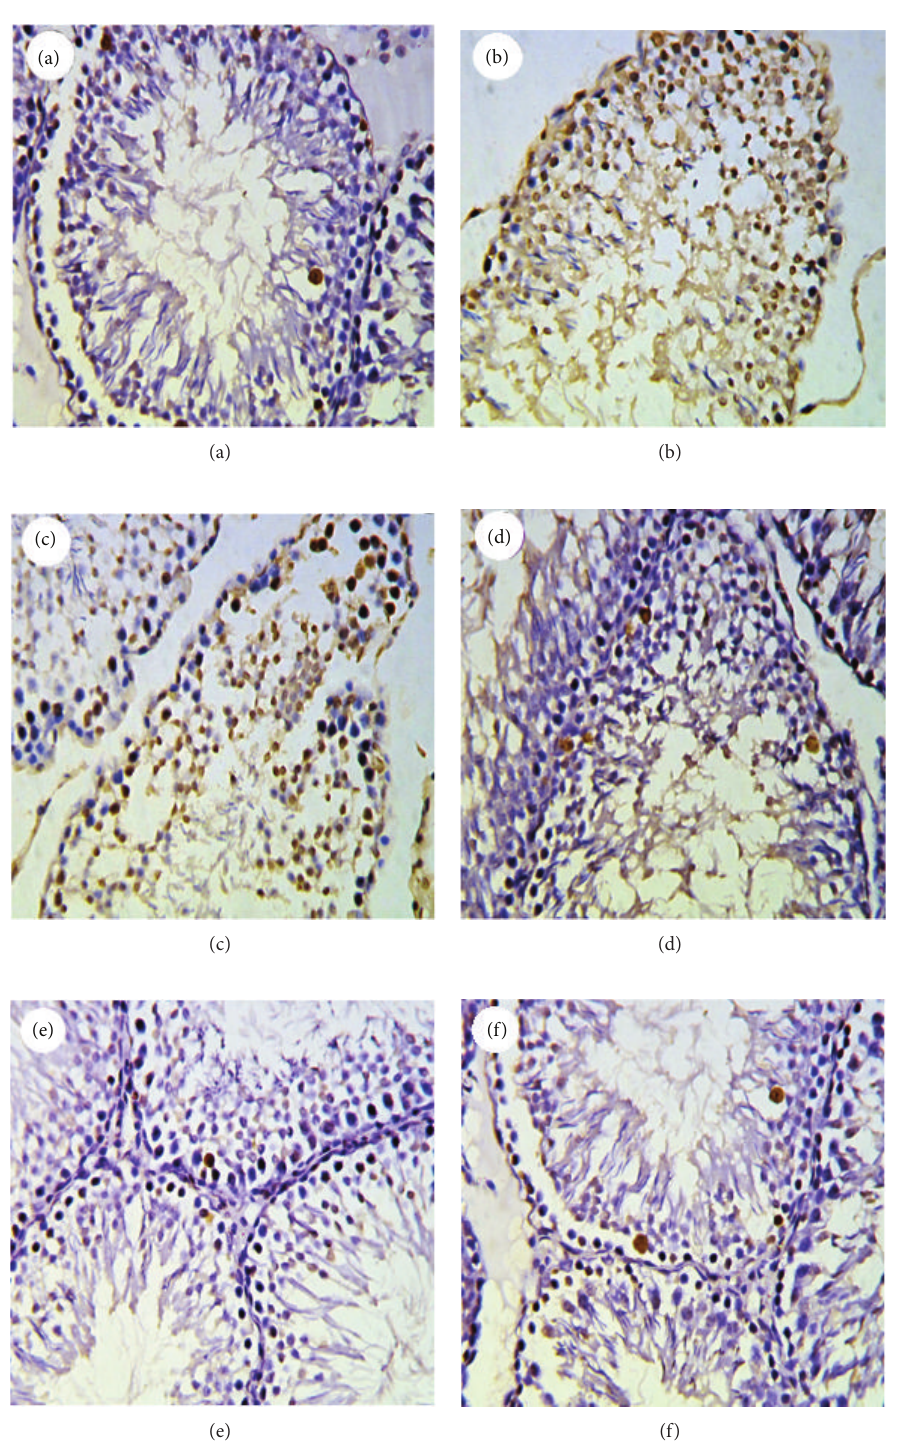
Figure 4: TUNEL staining of testicular tissue ( × 200). (a) Sham group: only a few TUNEL-positive cells were observed. (b) Torsion group and (c) torsion/detorsion (T/D) group: TUNEL-positive cells were mainly observed in germ cells of testis. (d), (e), and (f): T/D + LXA4 subgroup 1–3, respectively. Apoptotic cells were rarely observed in the seminiferous